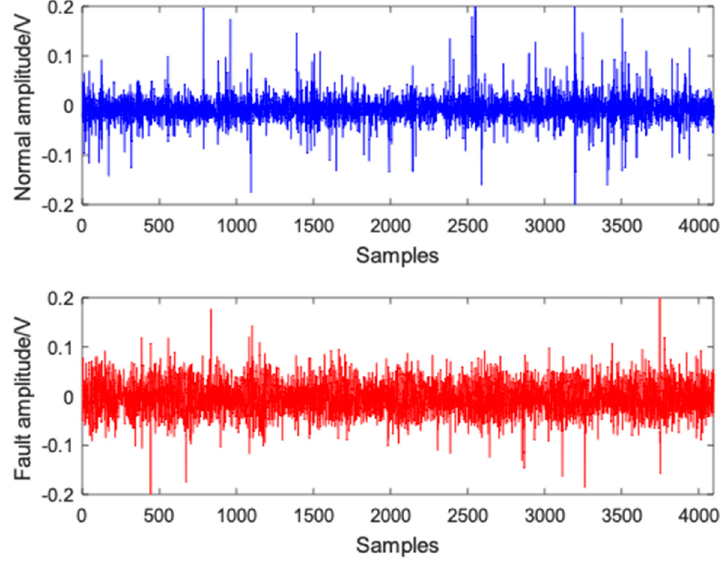
Figure 4. Two of the collected vibration signals.